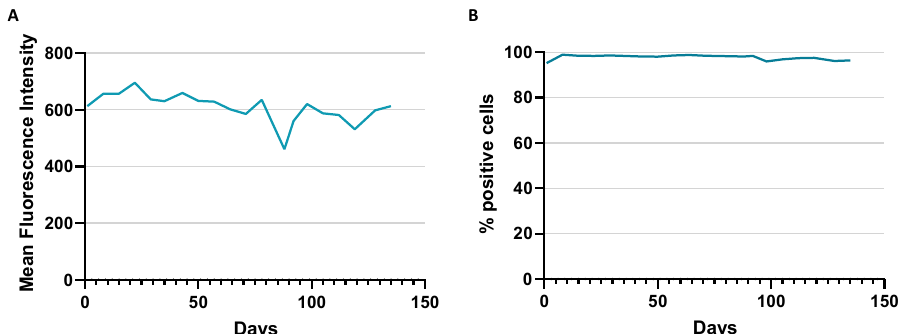
Figure 3. Stability of RFP expression of CHO clone RFP_A03 selected for landing pad containing CHO cell line. ( A ) RFP MFI values and ( B ) percentage of RFP-positive cells of RFP_A03 CHO cells during long-term culture of 135 days.